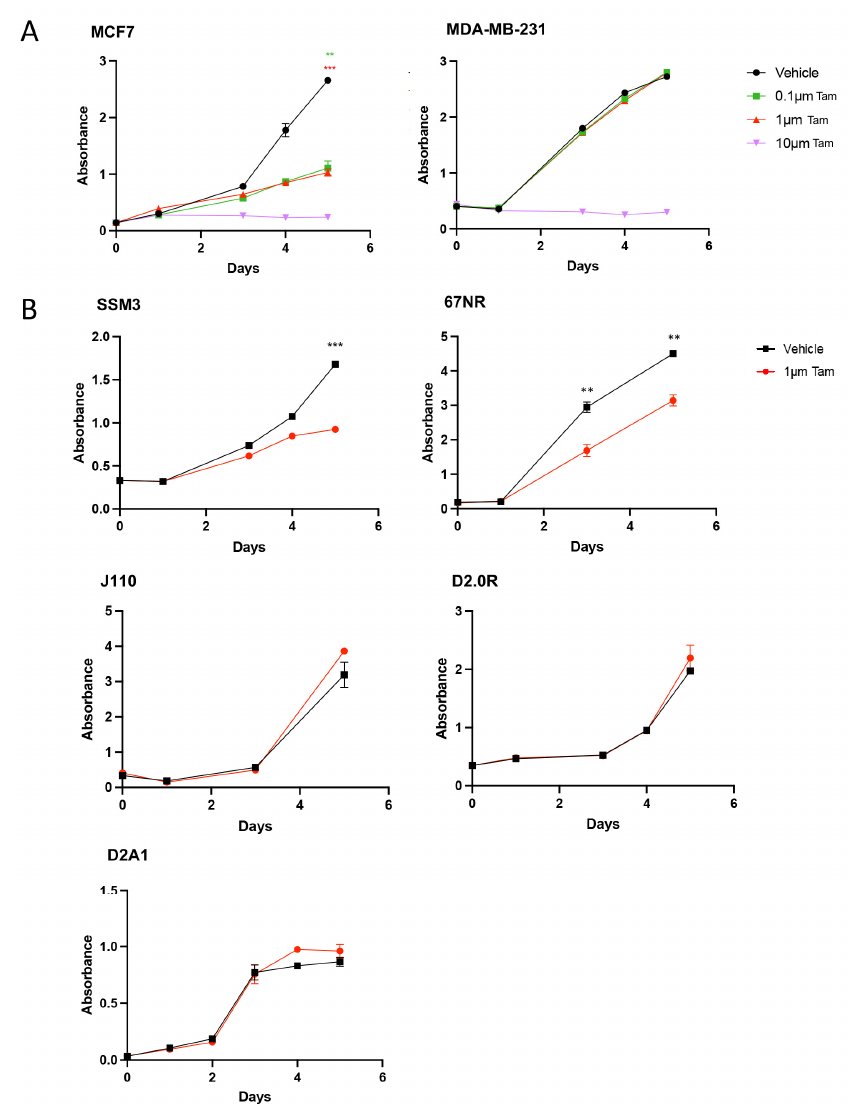
Figure 3. Response of syngeneic cell lines to tamoxifen treatment in vitro. Cells were incubated with either vehicle or 0.1 µM–10 µM 4-hydroxytamoxifen and proliferation was measured over 5–6 days (mean ± SEM of three to six replicate samples). ( A ) Response of commonly used human xenograft cell lines. MCF7 represents ER + cells and MDA-MB-231 represents ER-cells. Both respond as ex- pected. ( B ) Response of mouse mammary tumour lines. Tam, tamoxifen. Data shown as mean ± SEM. *** p ≤ 0.001, ** p ≤ 0.01.